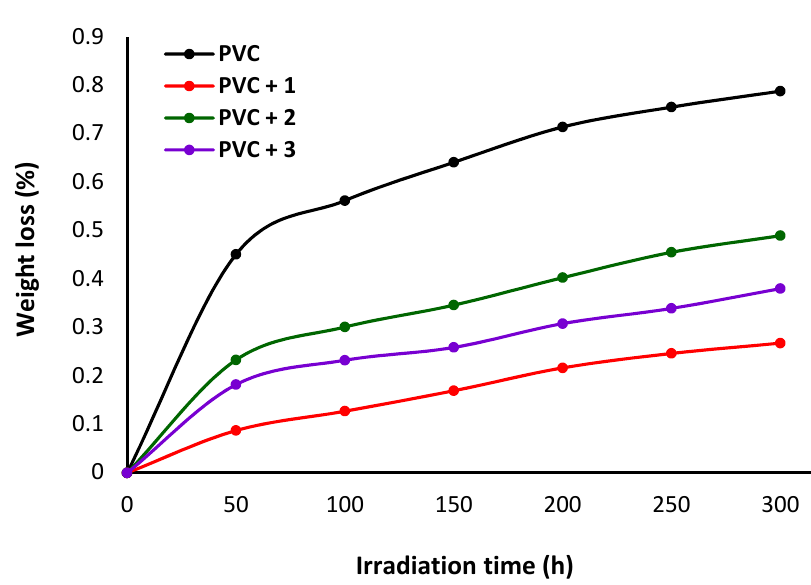
Figure 9. Changes in weight loss (%) upon irradiation.